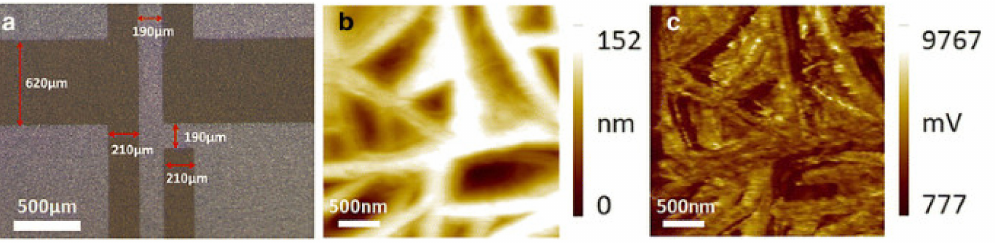
Figure 4. ( a )—surface morphology of the proposed sensor after etching technology; ( b )—Surface morphology and ( c ) PFM phase images of the PVDF sensor film [73].